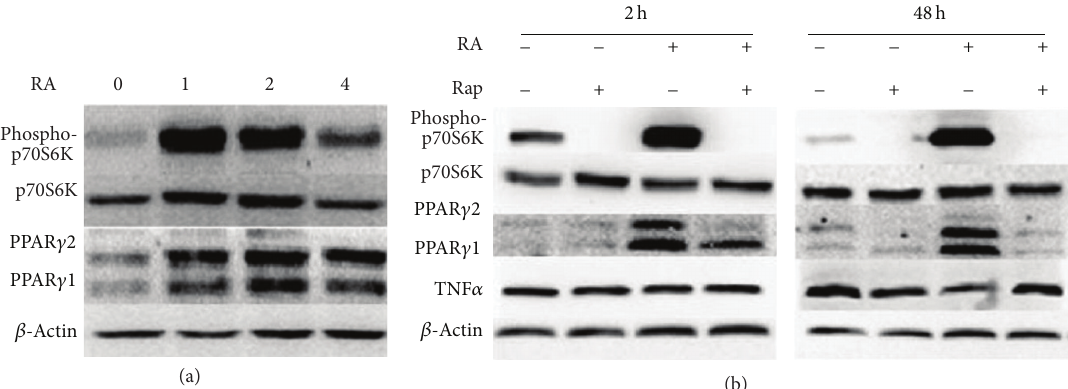
Figure 5: The mTORC1 signaling pathway plays an important role in the upregulation of PPAR 𝛾 expression by RA. (a) Differentiated 3T3-L1 cells were cultured with 0, 1, 2, and 4 mg/mL RA for 48 hours. Cell extracts were then subjected to western blot analysis with antibodies specific for total and phosphorylated p70S6K (Thr389), PPAR 𝛾 , and 𝛽 -actin. (b) Differentiated 3T3-L1 cells were cultured with rapamycin (0 or 30 nM) and RA (0 or 2mg/mL) for 2 or 48 hours. Cell extracts were then subjected to western blot analysis with antibodies specific for total and phosphorylated p70S6K (Thr389), PPAR 𝛾 , TNF 𝛼 , and 𝛽